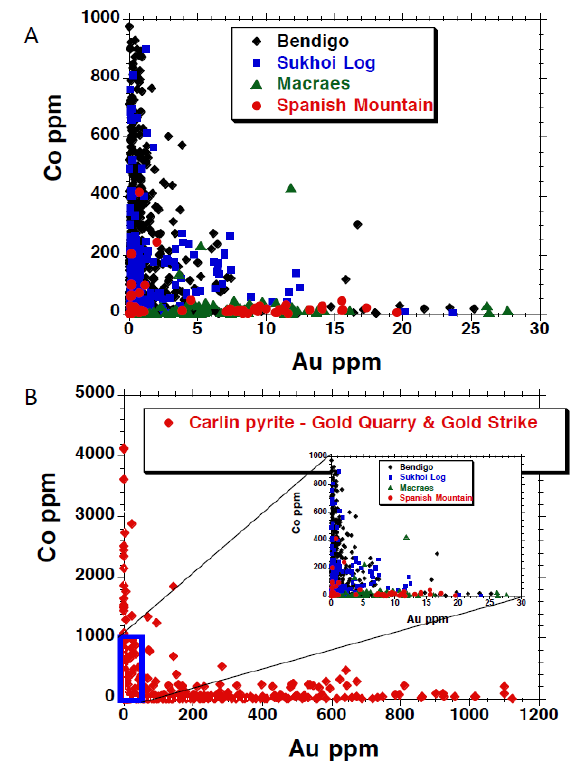
Figure 15. Co-Au relationships in pyrite from selected deposits demonstrates that the highest levels of Au occur in Co-poor pyrite.